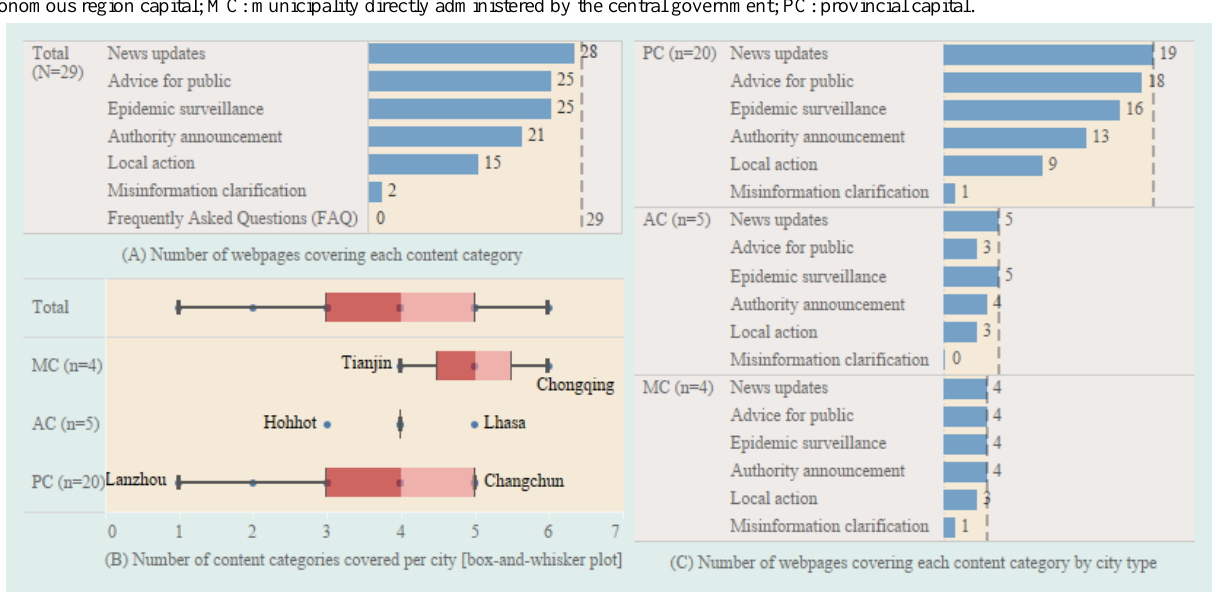
Figure 2. Description of content covered in the COVID-19 information webpages, March 2020. (A) Number of webpages covering each content category, summarized and identified from the cities’ COVID-19 webpages, as of March 2020. (B) Number of content categories covered per city; distribution was reported using a box-and-whisker plot and the blue dots with black text labels indicate the maximums and minimums. (C) Number of webpages covering each content category by city type, summarized and identified from the cities’ COVID-19 webpages, as of March 2020. AC: autonomous region capital; MC: municipality directly administered by the central government; PC: provincial